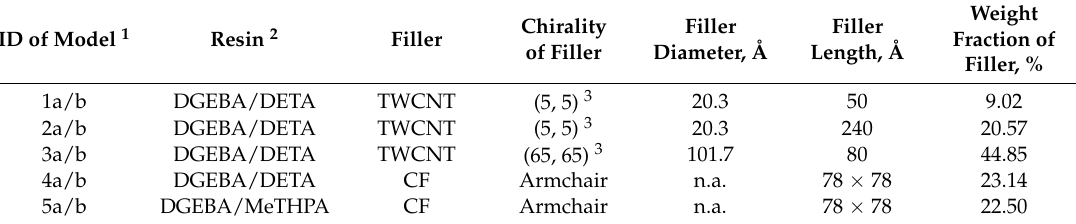
1 Type of models: a → non cross-linked; b → cross-linked; 2 Diglycidyl ether of bisphenol-A (DGEBA), diethylene triamine (DETA) and methyl tetrahydrophthalic acid (MeTHPA); 3 Refers only to the inner TWCNT layer: (5, 5) → (5, 5) (10, 10) (15, 15); (65, 65) → (65, 65) (70, 70) (75,